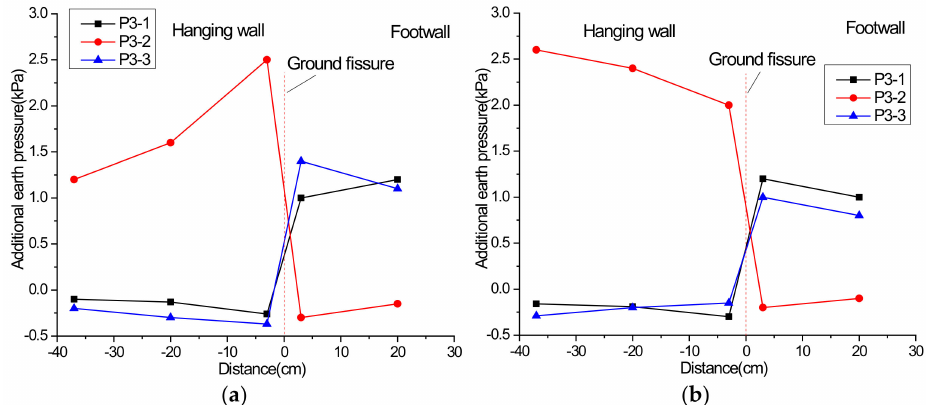
Figure 21. Additional earth pressure at 85 cm height under the scenario of hanging wall descending (1 cm): ( a ) vibration exciter at 60 cm; ( b ) vibration exciter at 100 cm.